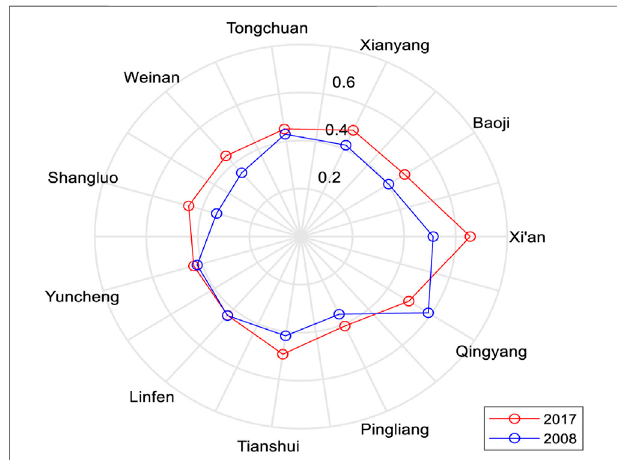
FIGURE 7 | Coupling coordination degree between urbanization development level and ecological environment quality of cities in GZPUA in 2008 and